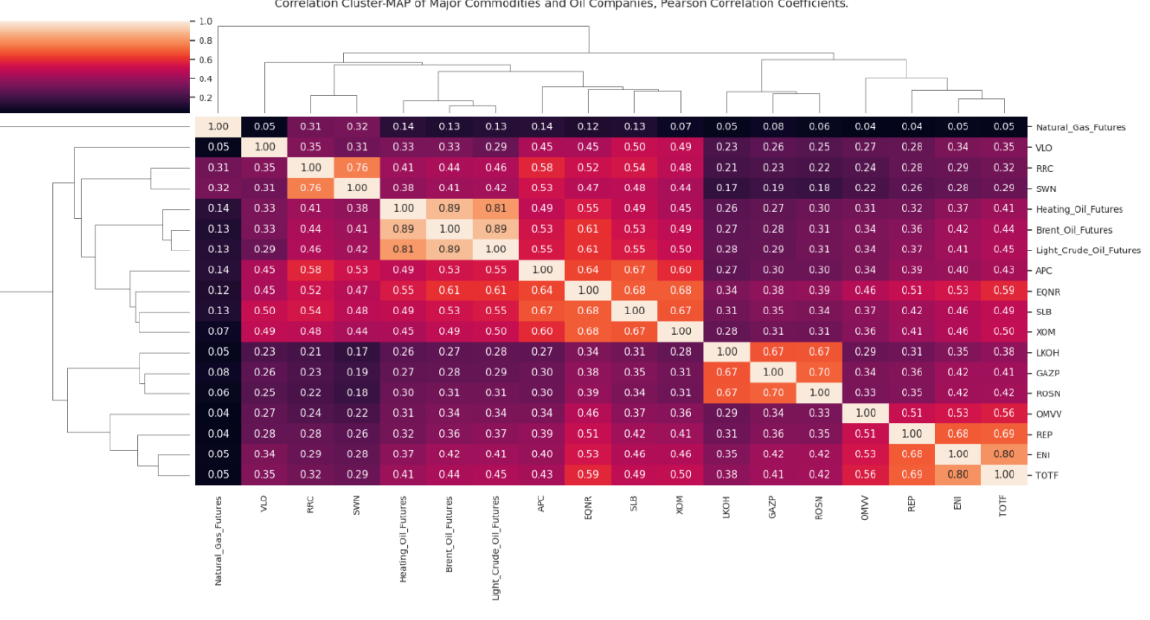
Figure 1: Correlation cluster map of daily energy, soft and hard commodity futures returns, observation period 2012-2018. Gas futures occupy a separated position outside the clusterings pattern showing a low correlation with the United States (US) oil company stocks RRC and SWN. Other relationships were identified among the daily stock futures returns of APC, EQNR (Norway), SLB (Netherlands), and XOM (US), as well as among the Russian oil company stocks Lukoil, Gazprom, and Rosneft. The closely related price development of ENI (Italy), TOTF (France), REP (Spain), and OMVV (Austria) is denoted on the right side of the heat- map's bottom in decreasing